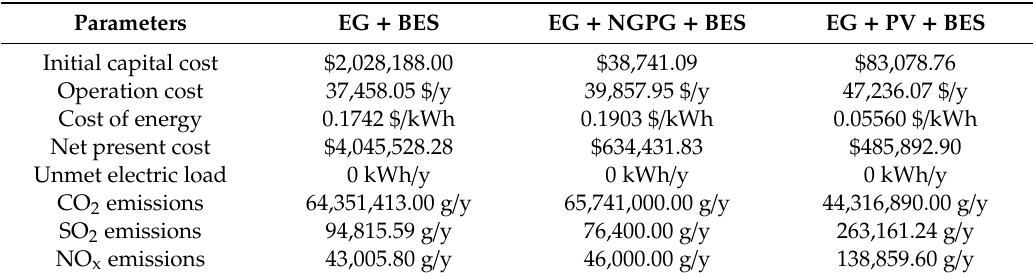
Table 9. Comparison of resilience and techno-economic and life cycle based environmental feasibility indicators for three PSS configurations.